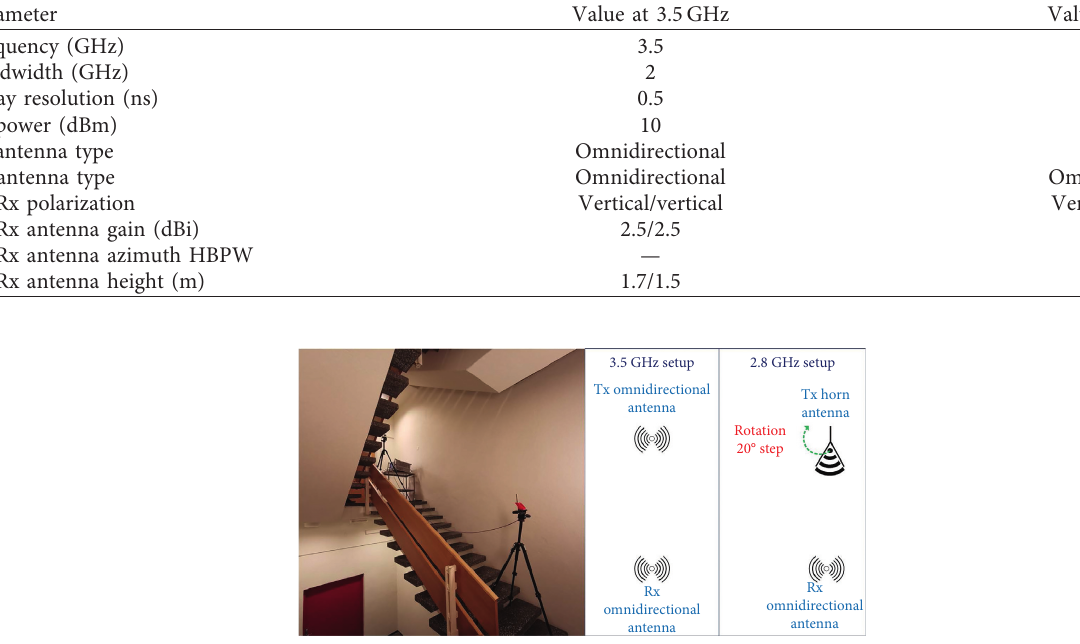
Figure 1: Measurement setup. Tx was fixed at the top of the stair, and Rx was moved along the stair